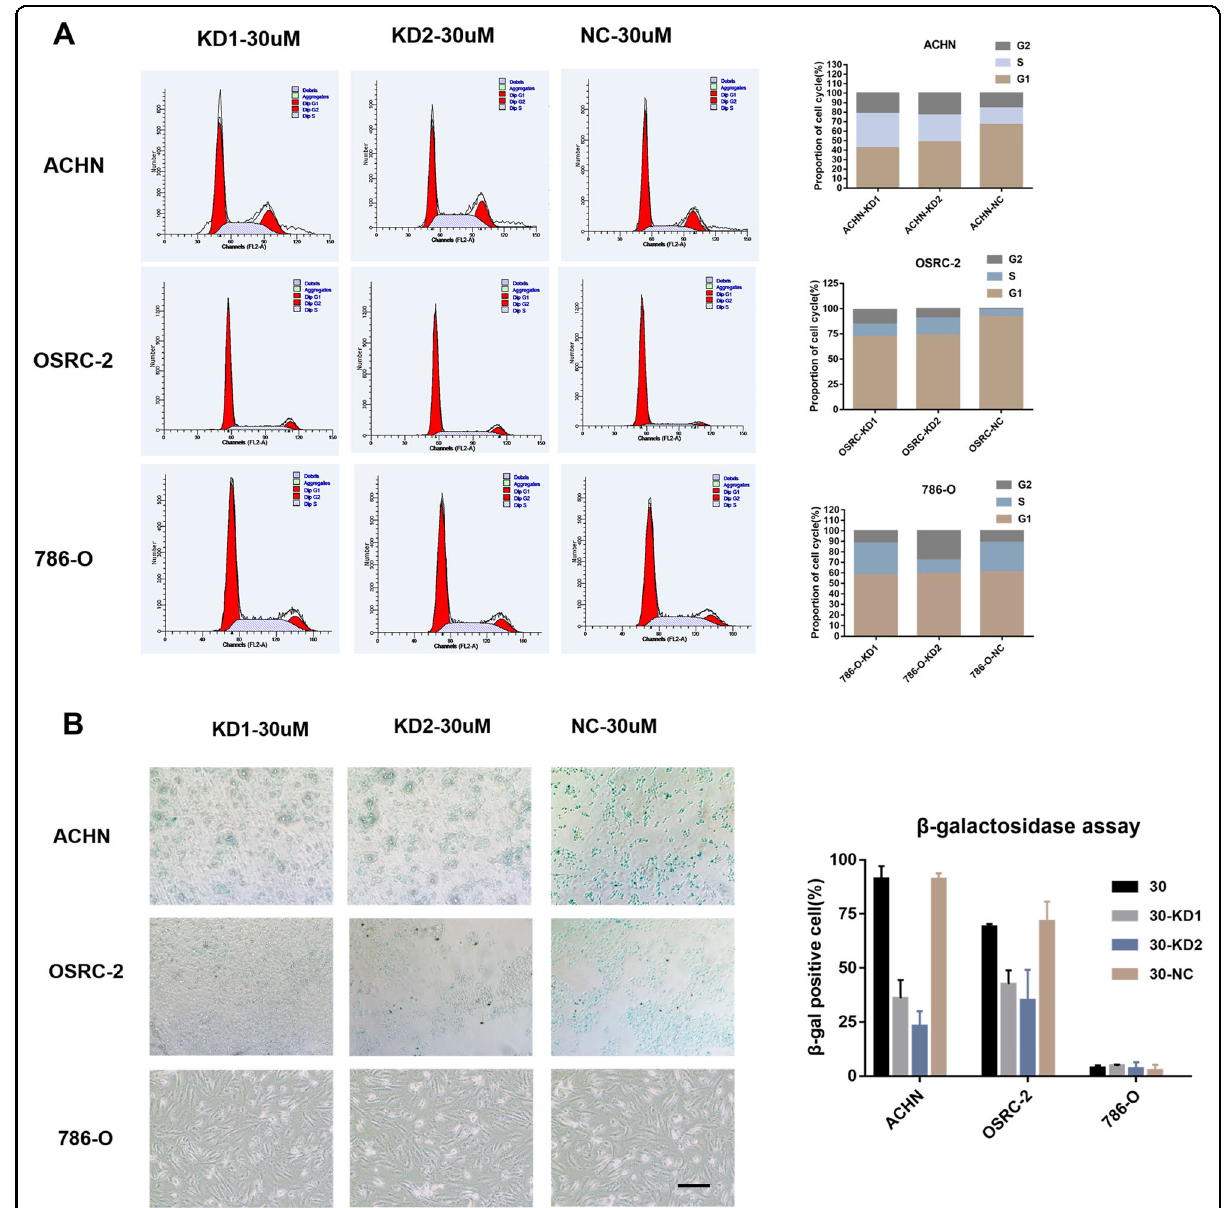
Fig. 4 P53BER2 could mediate cell-cycle arrest and senescence in TP53-WT renal cancer cell lines. A The proportion of cell cycle of different RCC cell lines infected p53BER2-KD virus and vectors after nutlin-3 treatment. B The rate of senescence cell in different RCC cell lines infected p53BER2-KD virus and vectors after nutlin-3 treatment, scale bar, 100 μ m. Results are shown as mean ± SD. *** P < 0.001 compared with control. ** P < 0.01 compared with control. * P < 0.05 compared with